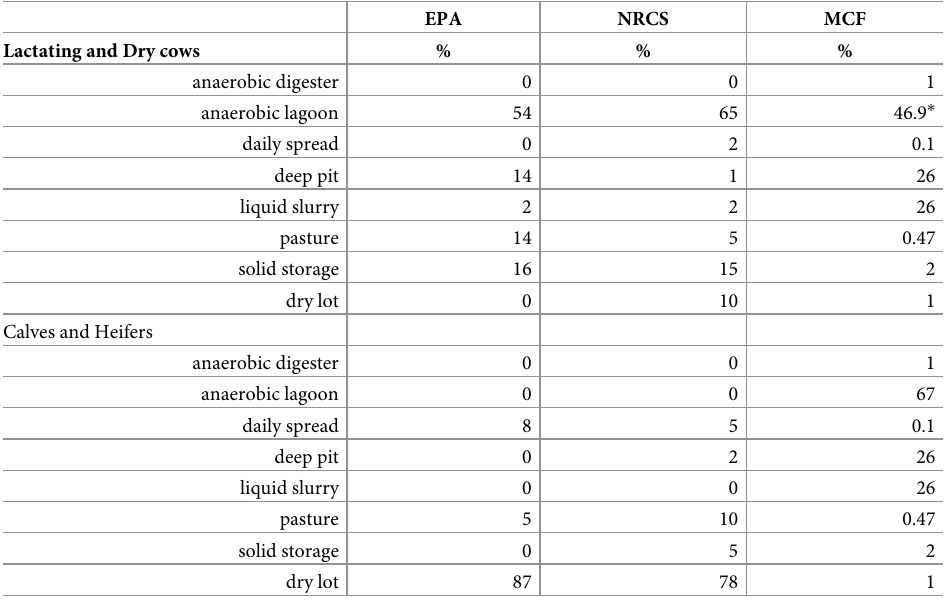
Table 4. The proportion of manure management system reported by EPA and NRCS in South Dakota. Methane conversion factor (MCF) from IPCC (2019) is also provided.